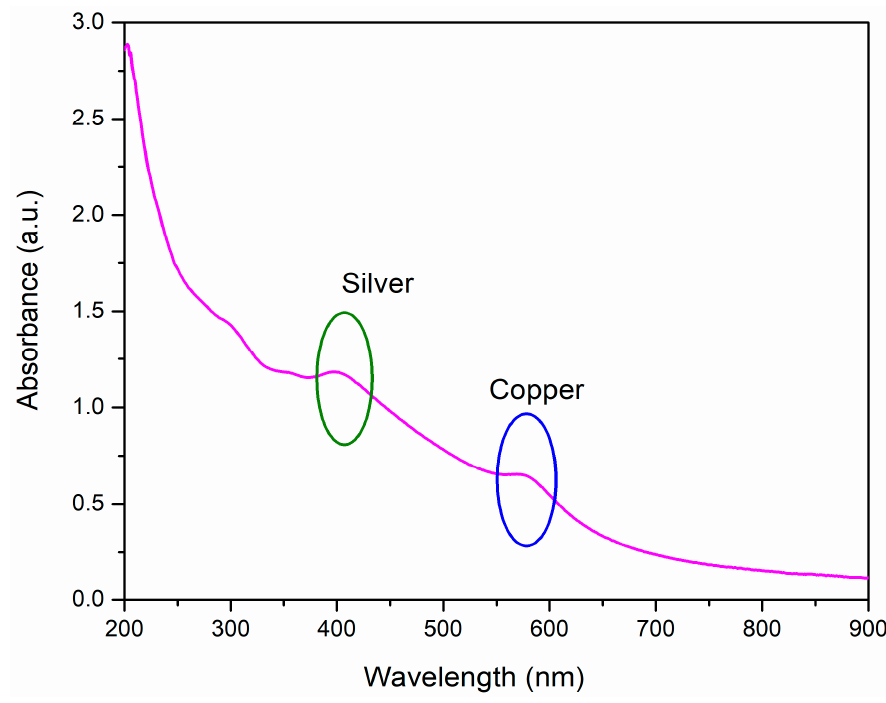
Figure 1. UV-Vis spectra of copper-silver bimetallic nanostructures.